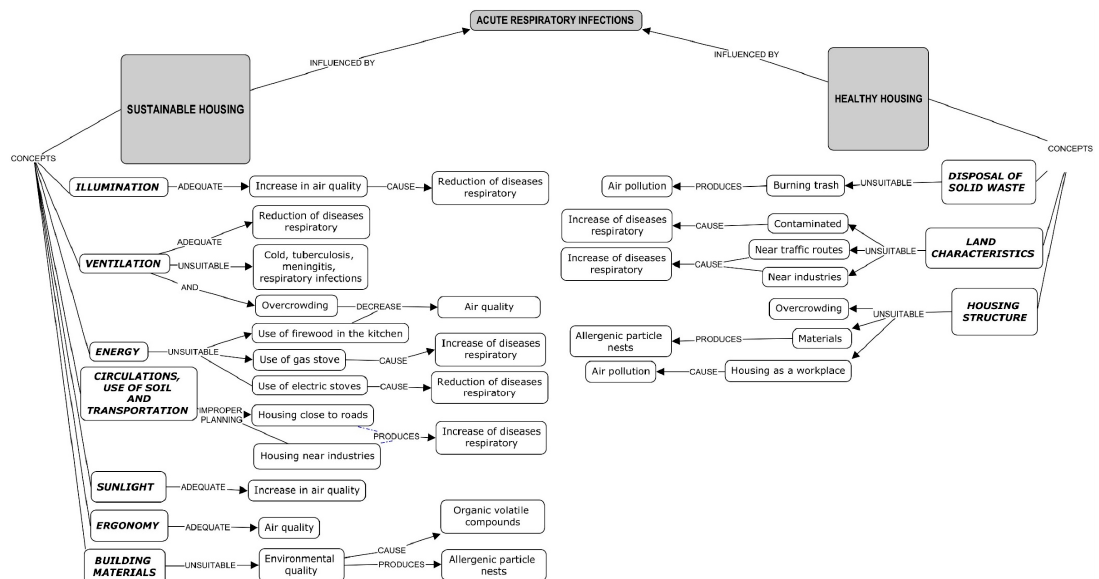
Figure 1. Conceptual framework considering the relationship between acute respiratory infections, sustainable housing, and healthy housing. Source: Own creation [1,4–9,11–13,22,34–37,39].